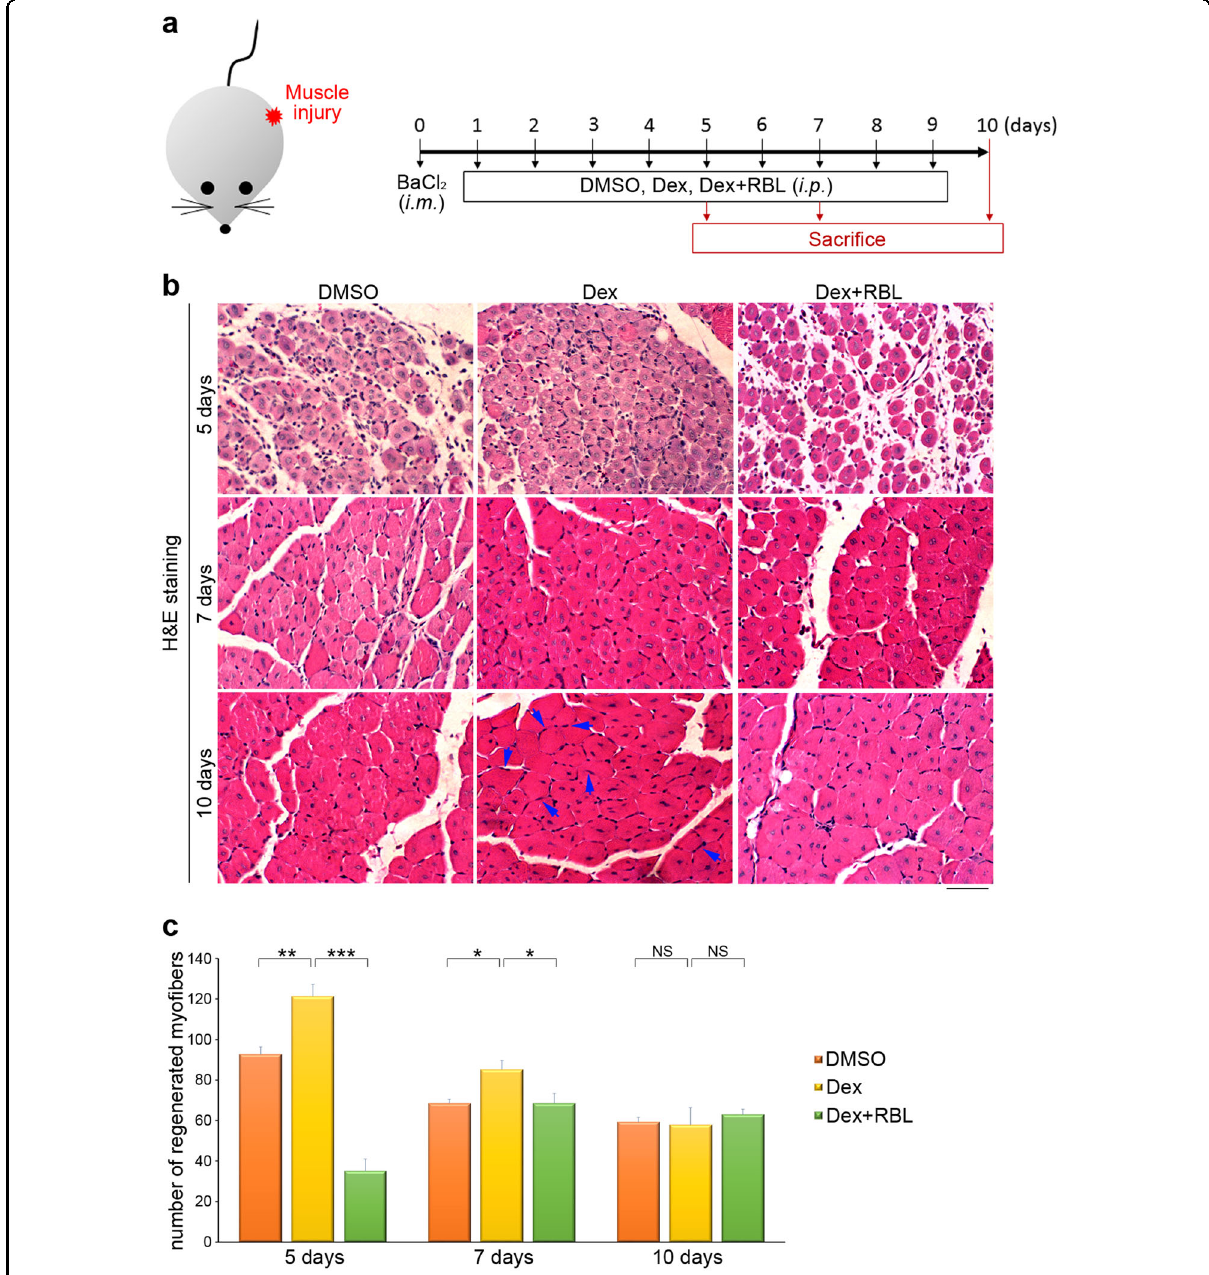
Fig. 2 Kinesin-1 drives muscle regeneration in mice. a Experimental scheme for the skeletal muscle regeneration experiments. The tibialis anterior (TA) muscles in the left hind legs of mice were injured using 1.2% BaCl 2 via intramuscular (i.m.) injection on day 0. Next, the mice were randomly grouped and administered with DMSO, Dex (0.1 mg/kg) or Dex (0.1 mg/kg) + RBL (30 mg/kg) everyday via intraperitoneal (i.p.) injection. To assess whether Dex is able to accelerate skeletal muscle regeneration via kinesin-1, mouse TA muscle samples were collected at various time points. b Representative histology images of mouse TA muscles of the various study groups. The regenerating myo fi bers with peripheral nuclei marked with blue arrows. Scale bar, 50 μ m. c The number of regenerative muscle fi bers, calculated as the number of fi bers with accumulation of centrally located nuclei, as shown in b . Data are mean ± s.e.m ( n = 5 independent fi elds). * p < 0.05; ** p < 0.01; *** p < 0.001; NS no signi fi